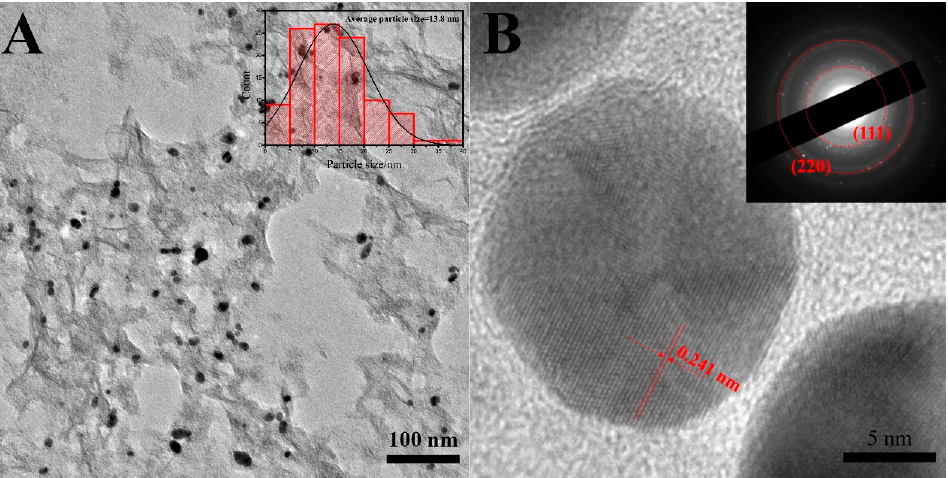
Figure 3. TEM images ( A ) of 3D Au-rGO and inset shows the particle size distribution, HRTEM images ( B ) of Au and inset shows the SAED pattern.